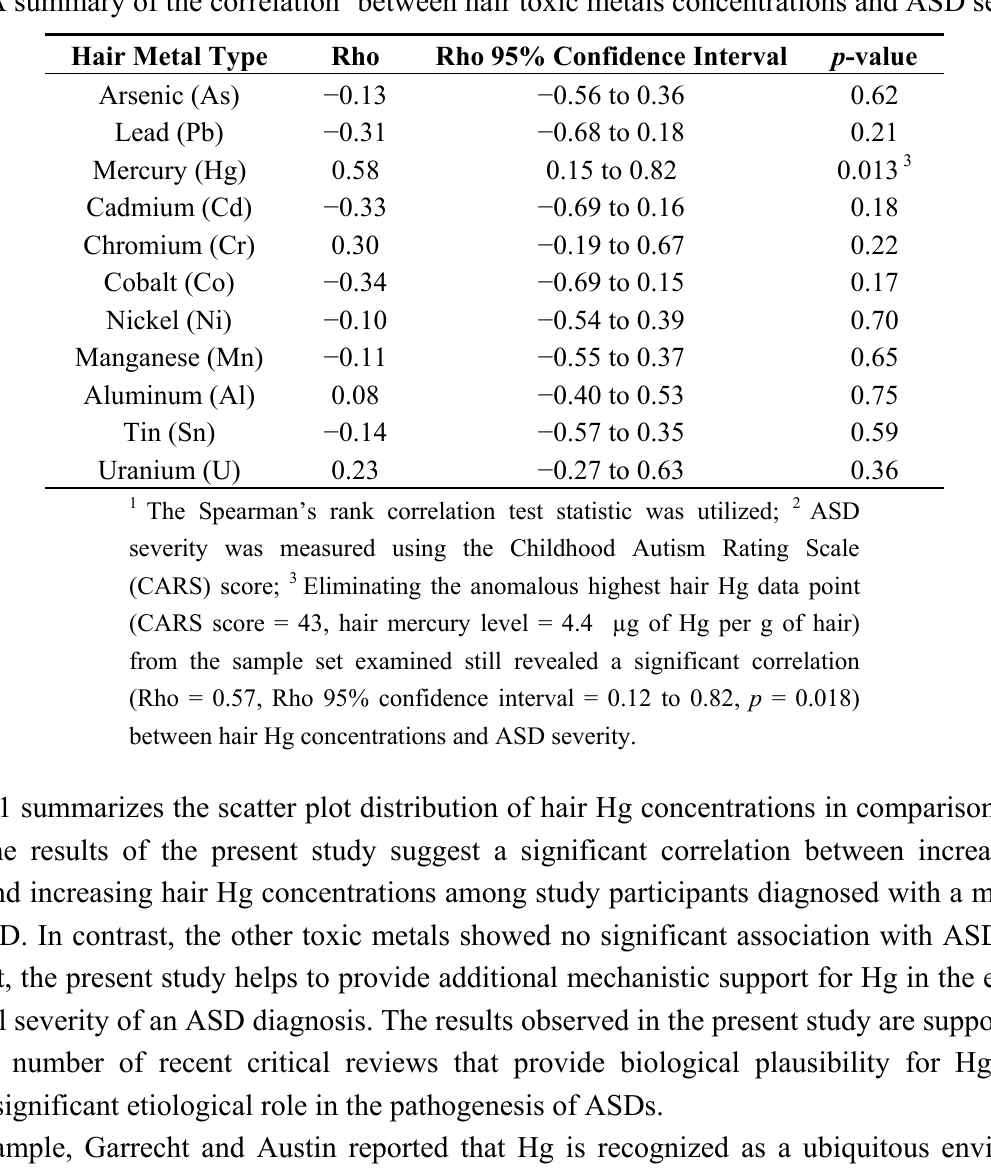
Table 3. A summary of the correlation 1 between hair toxic metals concentrations and ASD severity 2